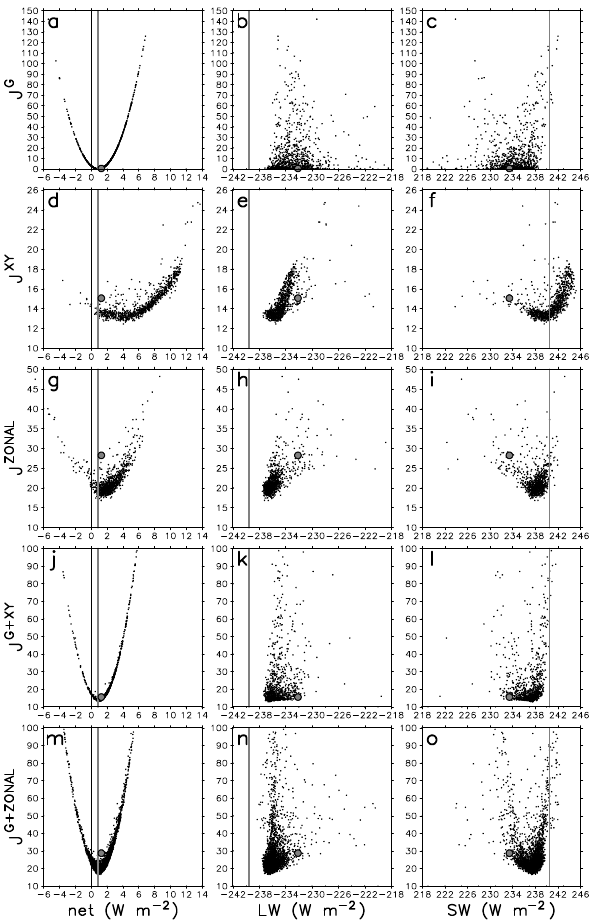
Fig. 6. The objective function versus global annual mean radia- tive fluxes (net, LW, and SW). The vertical grey line represents the observed global annual mean value in CERES data (0 . 9Wm − 2 , − 239 . 6Wm − 2 and 240 . 5Wm − 2 for net, LW, and SW fluxes, re- spectively), and the grey dot corresponds to the default parameter